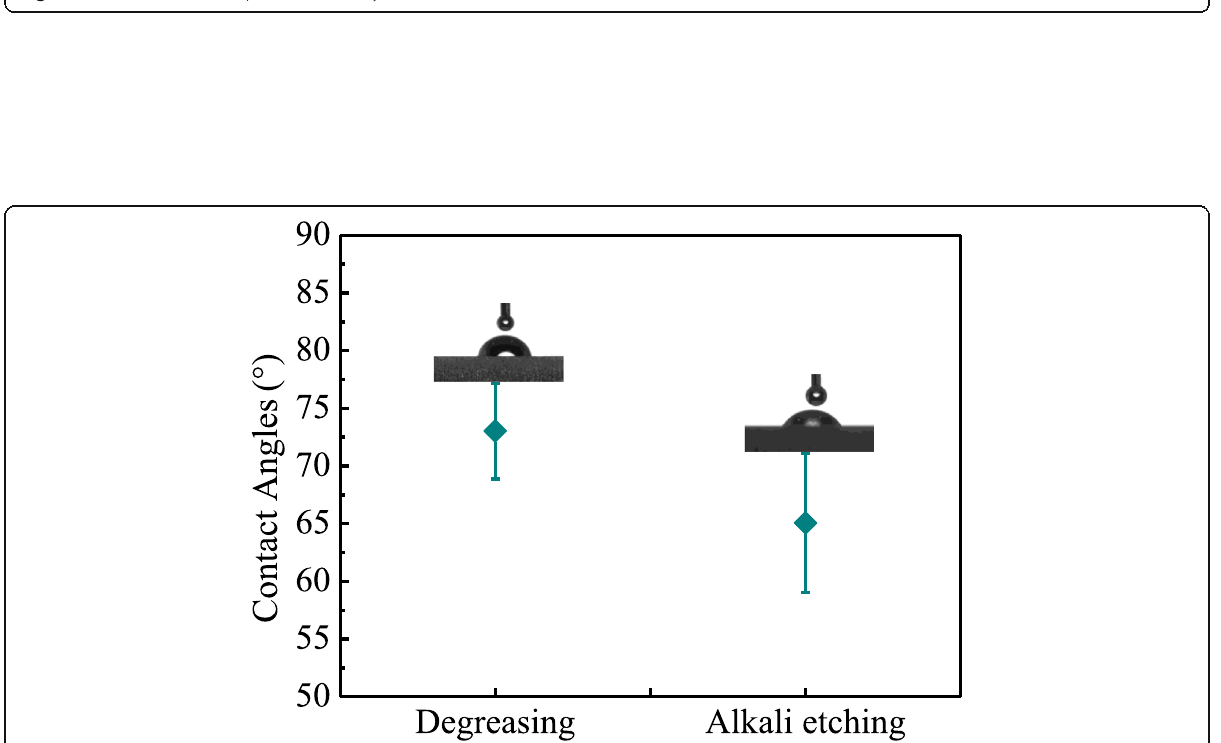
Fig. 6 Narrow scan of XPS spectra of Al alloy surface